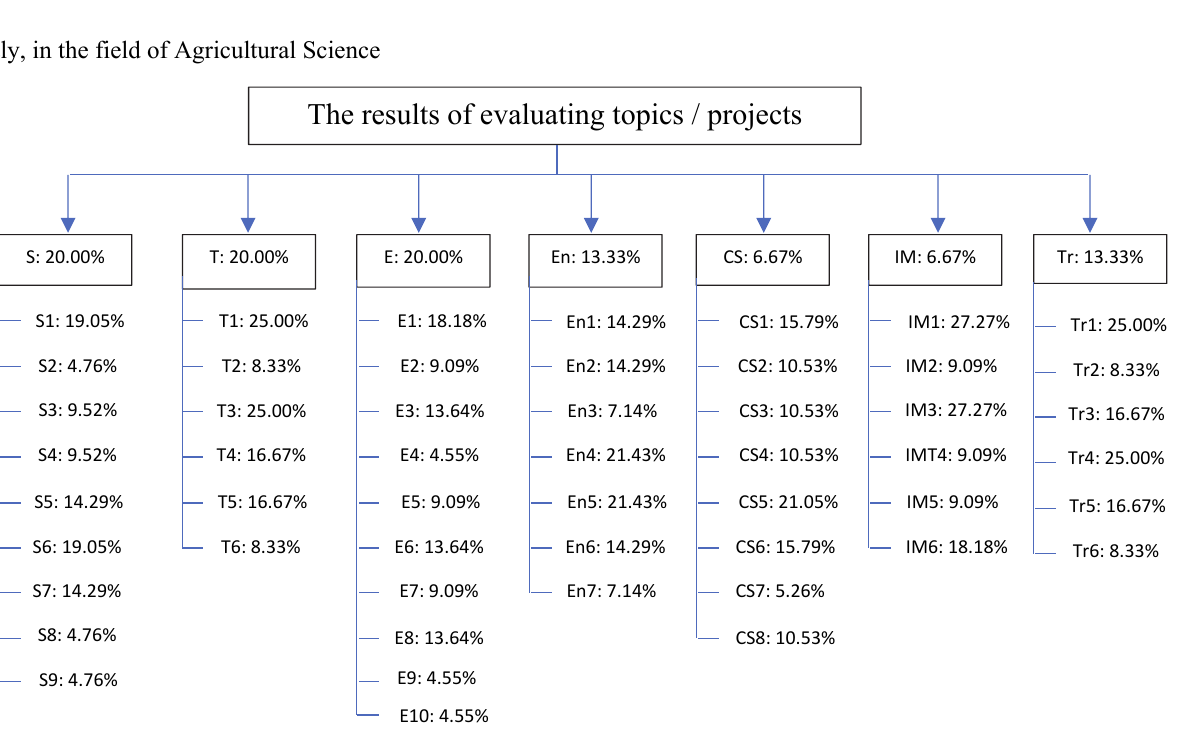
Fig. 3. Weight of each criterion for evaluating socio-economic efficiency of Agricultural Science topics /